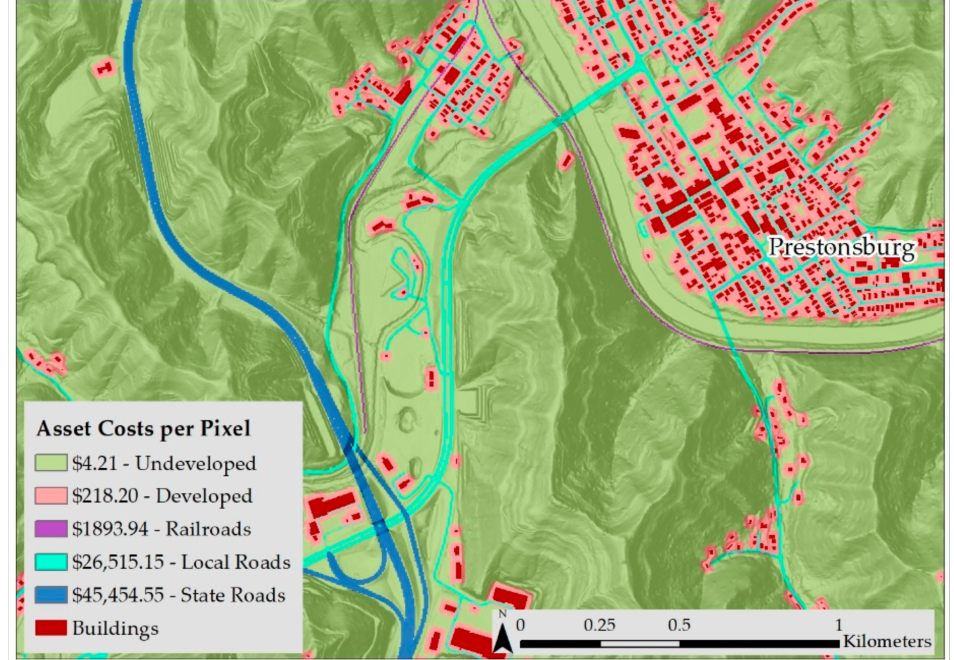
Figure 9. Cost-per-pixel map of part of Floyd County in the Big Sandy Area Development District. Values are in U.S.